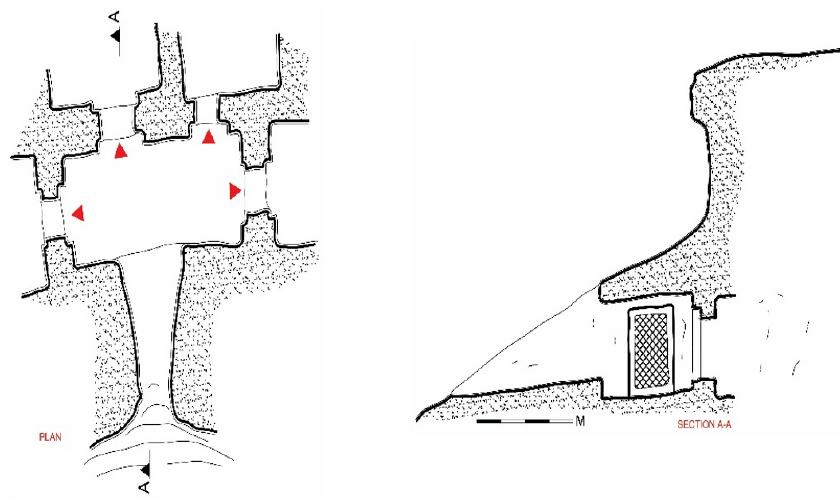
Figure 19. The third stage of excavation of doorways (Dargah) in cross-section and plan view.